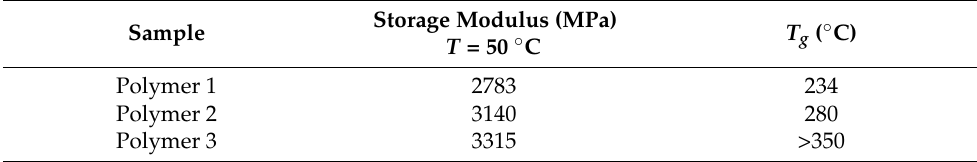
Table 3. Thermal–mechanical properties of the DPTP PN